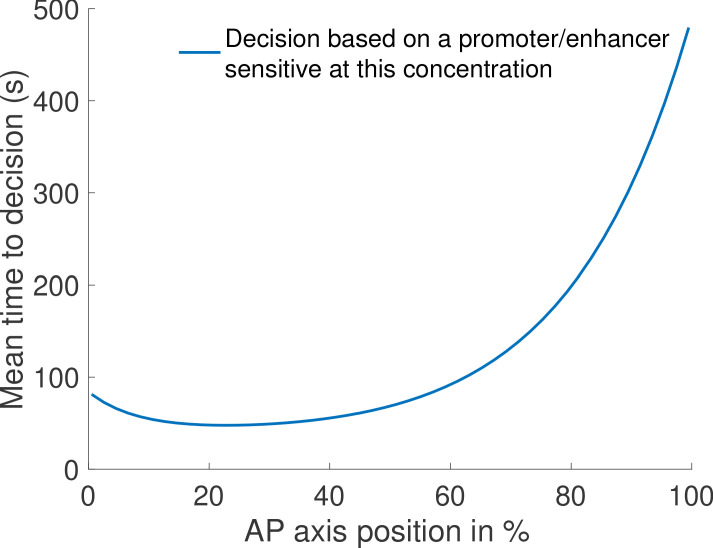
Mean time to decision across the embryo based on local Bicoid concentration difference.For each position across the embryo, we compute the performance of the fastest identified architecture (k=1, no Hill coefficient constraint) if it was implemented to distinguish between two concentrations with 10% relative variation, and an average equal to the Bicoid concentration at the AP position denoted on the x-axes. We find that our architecture performs well in the anterior region but is slow in the posterior region, due to low concentrations.